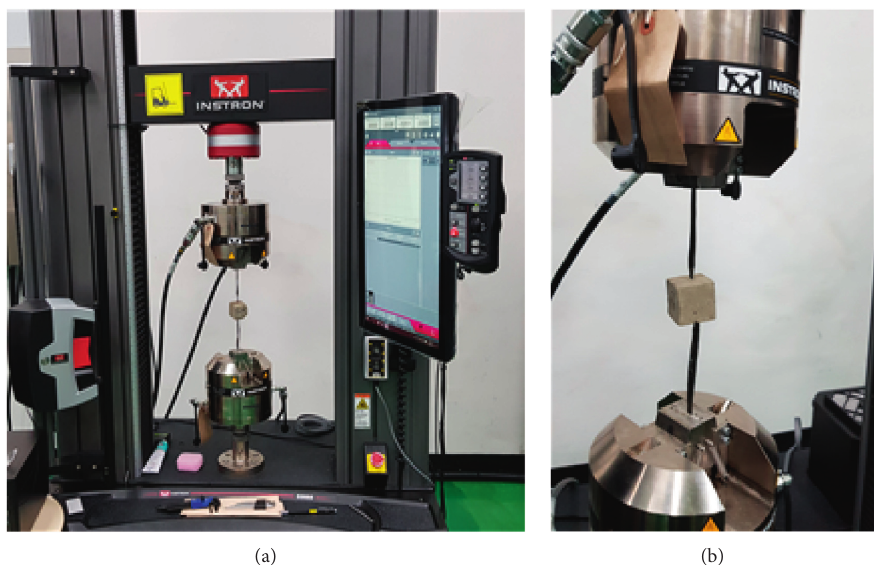
Figure 3: Specimen installation and experimental setup for the pull-out test of the tow carbon